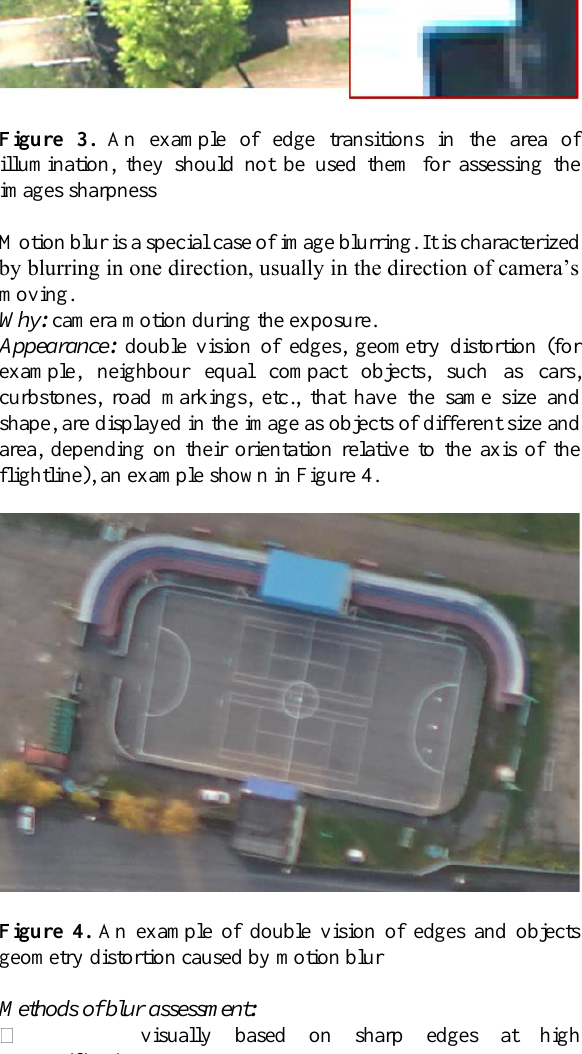
Image’s blurring (including motion blurring) Why: linear and angular carrier motions during aerial surveying. blurred transition bands.